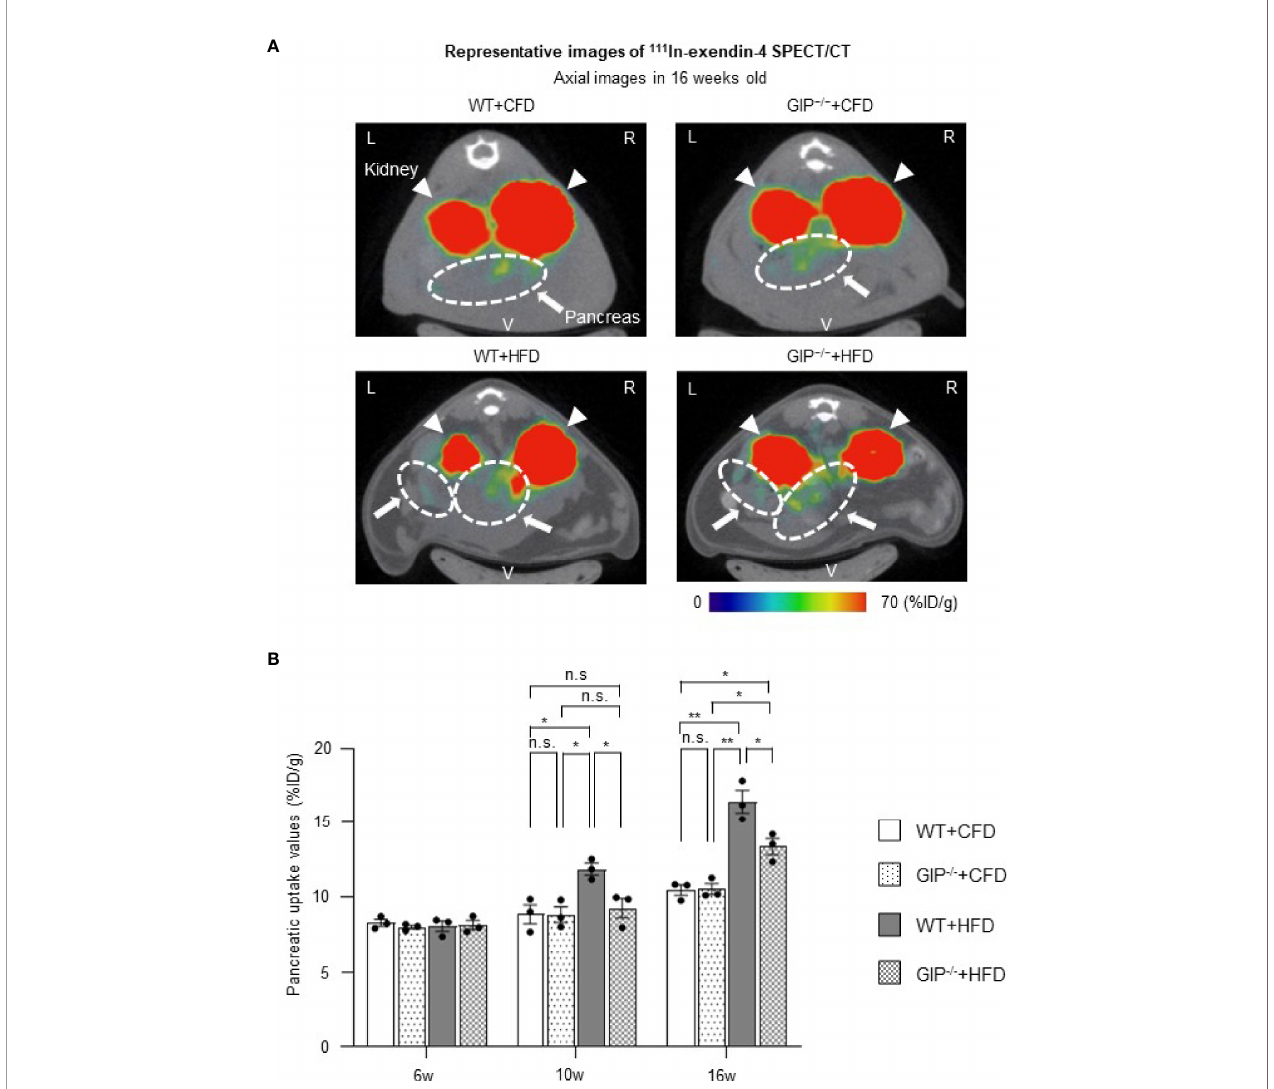
FIGURE 3 | BCM changes based on 111 In-exendin-4 SPECT/CT during the observation period. (A) Representative axial images of in-vivo 111 In-exendin-4 SPECT/ CT at 16 weeks of age in each group. The maximum to minimum intensity is indicated by color: red > orange > yellow > green > blue > black. Signals from the pancreas are indicated by white arrows and circles; signals from the kidney are indicated by white arrowheads. L, left; R, right; V, ventral. (B) Longitudinal changes in pancreatic uptake of in-vivo 111 In-exendin-4 SPECT/CT. Pancreatic uptake values represent the percentage of injected dose/1g (%ID/g). WT mice fed control-fat diet (WT+CFD) are indicated by white bars with solid borders (n = 3). GIP -/- mice fed control-fat diet (GIP -/- +CFD) are indicated by dotted bars with solid borders (n = 3). WT mice fed high-fat diet (WT+HFD) are indicated by gray bars (n = 3). GIP -/- mice fed high-fat diet (GIP -/- +HFD) are indicated by checkerboard bars (n = 3). P values are expressed as follows: *P < 0.05, **P < 0.01 (one way ANOVA with Tukey ’ s test). n.s., no statistical signi fi